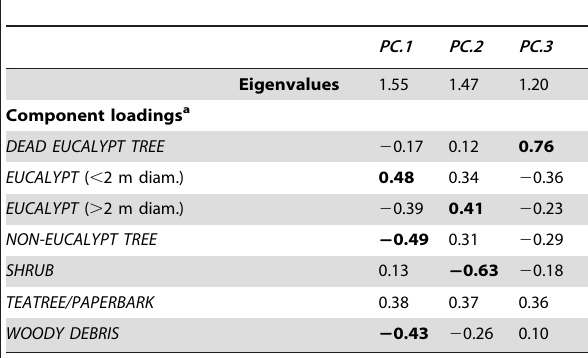
Table 13. Eigenvalues and component loadings from principal component analysis of simplified microhabitat